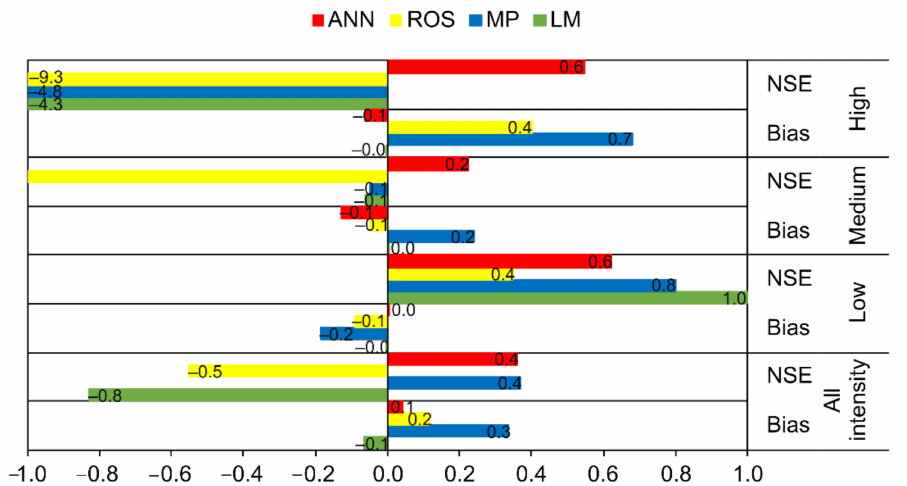
Figure 7. Bar plot of bias and NSE for the estimated radar rainfall